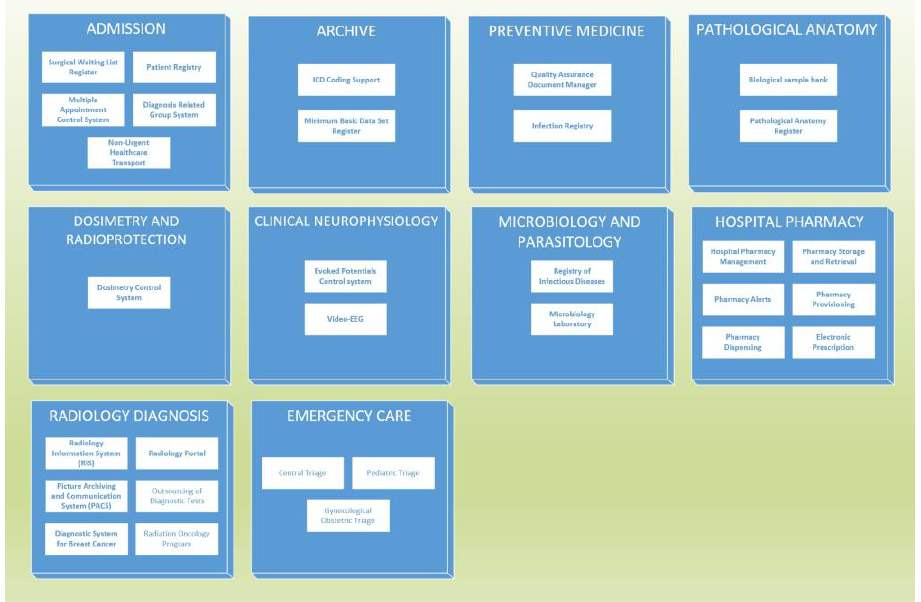
Figure 4. Relationship of information systems within clinical areas (II).